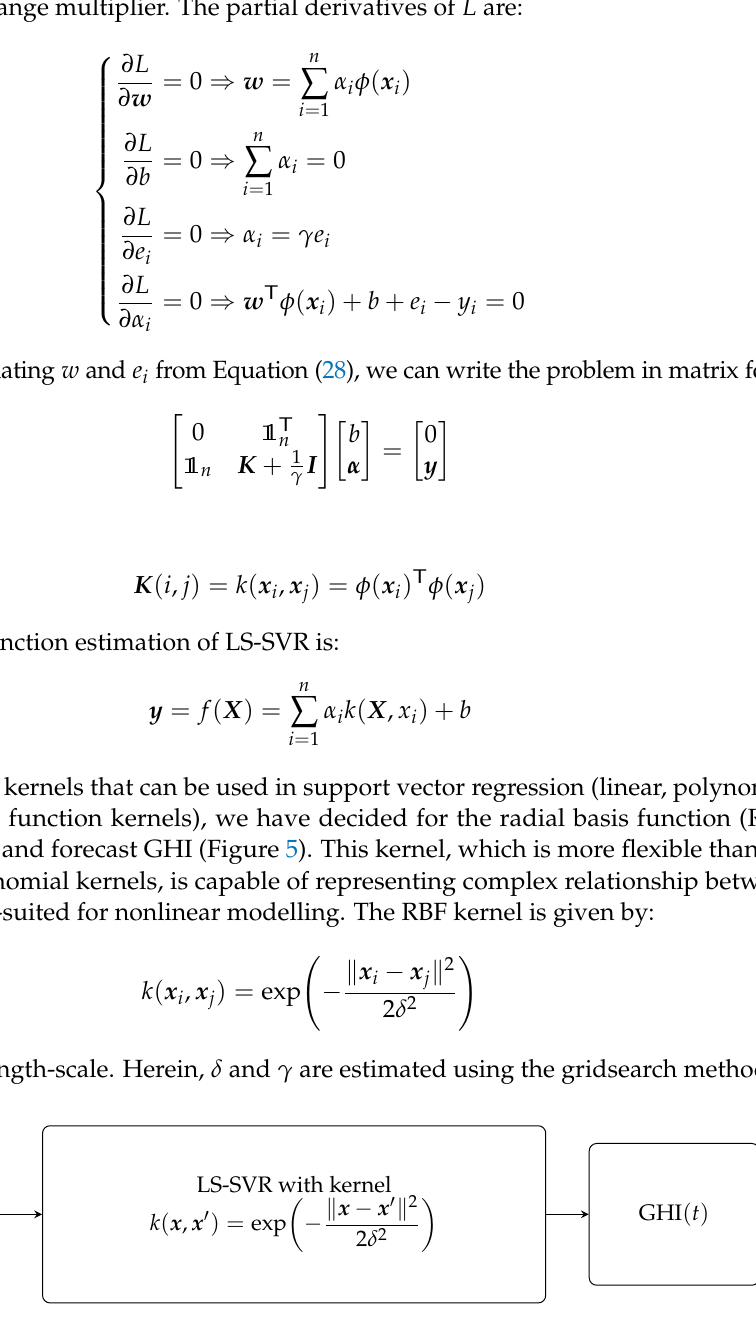
Figure 5. LS-SVR forecasting model based on the RBF kernel. GHI ( t − ∆ t ) , GHI ( t − 2 ∆ t ) , . . . , GHI ( t − D ∆ t ) is the observation set and ∆ t = 10min is the time